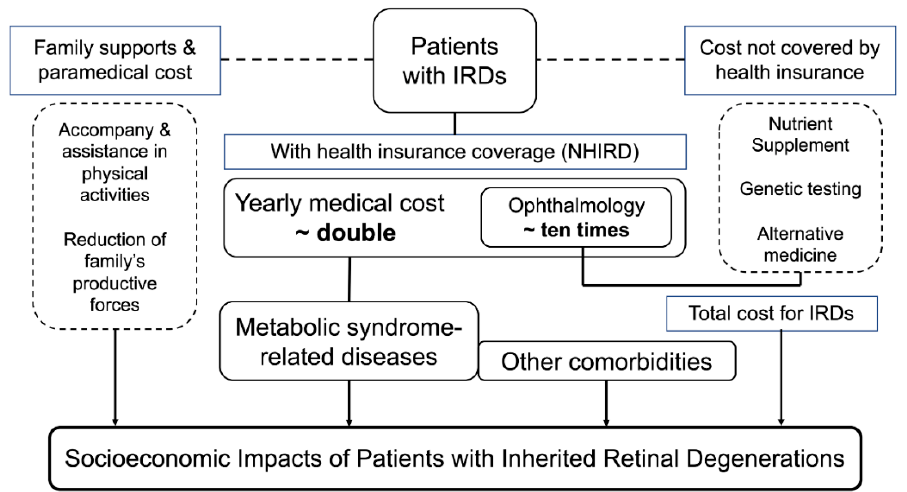
Figure 7. A brief summary of medical and socioeconomic impacts of inherited retinal degenerations. Abbreviations: IRD, inherited retinal degeneration.